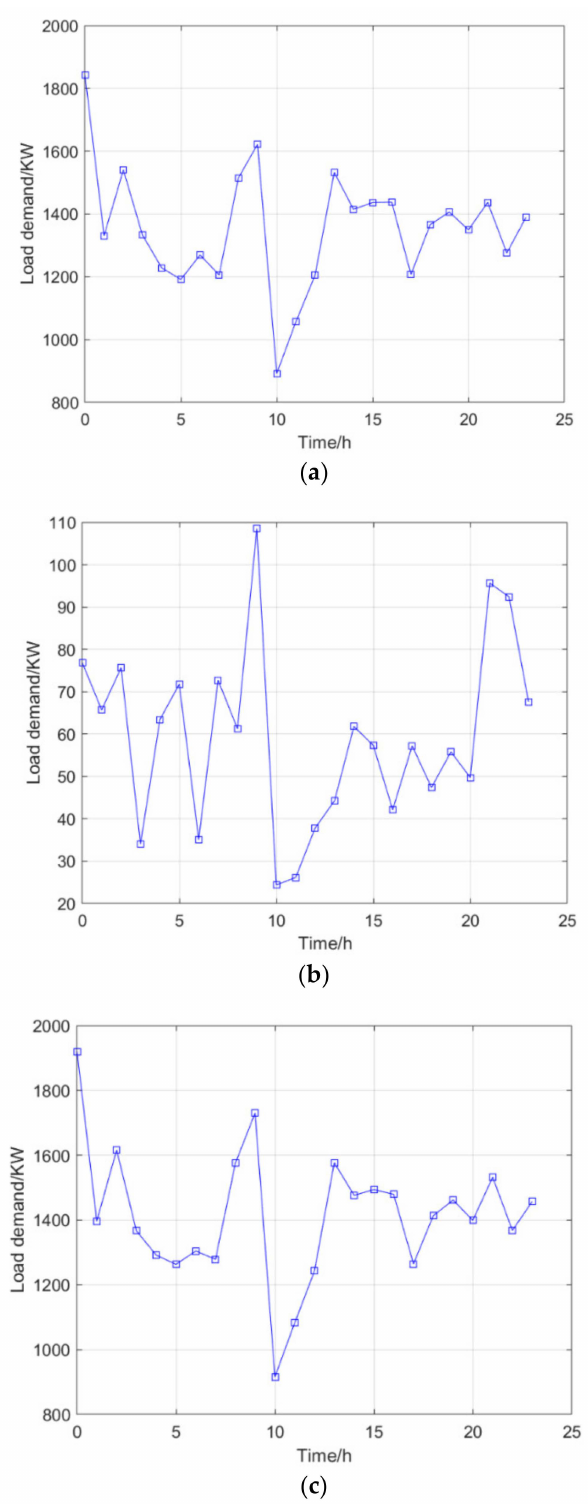
Figure 19. Fast charging demand load at 100 electric taxis. ( a ) Charging demand generated by electric taxis in charging stations. ( b ) Charging demand for electric taxis at their current location. ( c ) Charging needs generated by electric